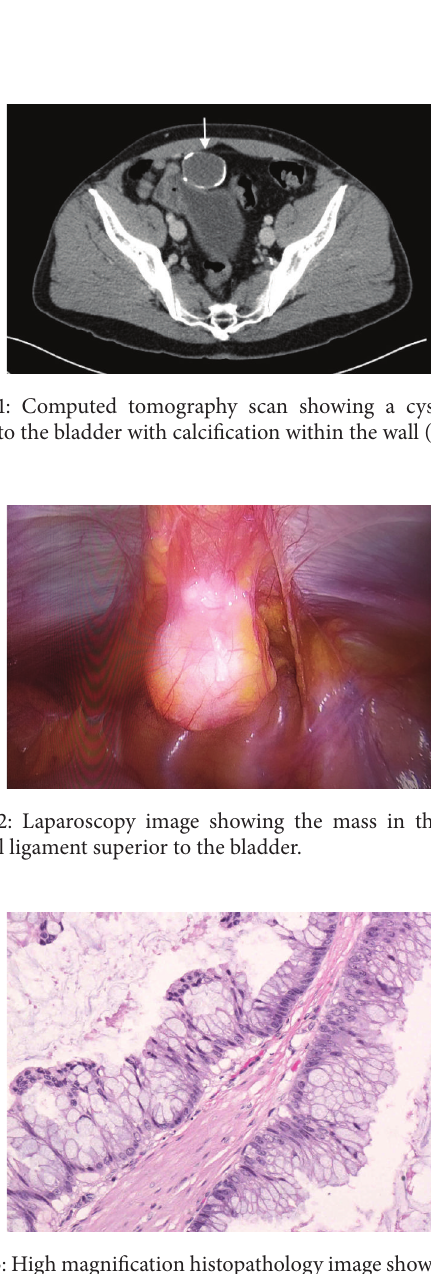
Figure 3: High magnification histopathology image showing goblet cells with pseudostratification and low-grade